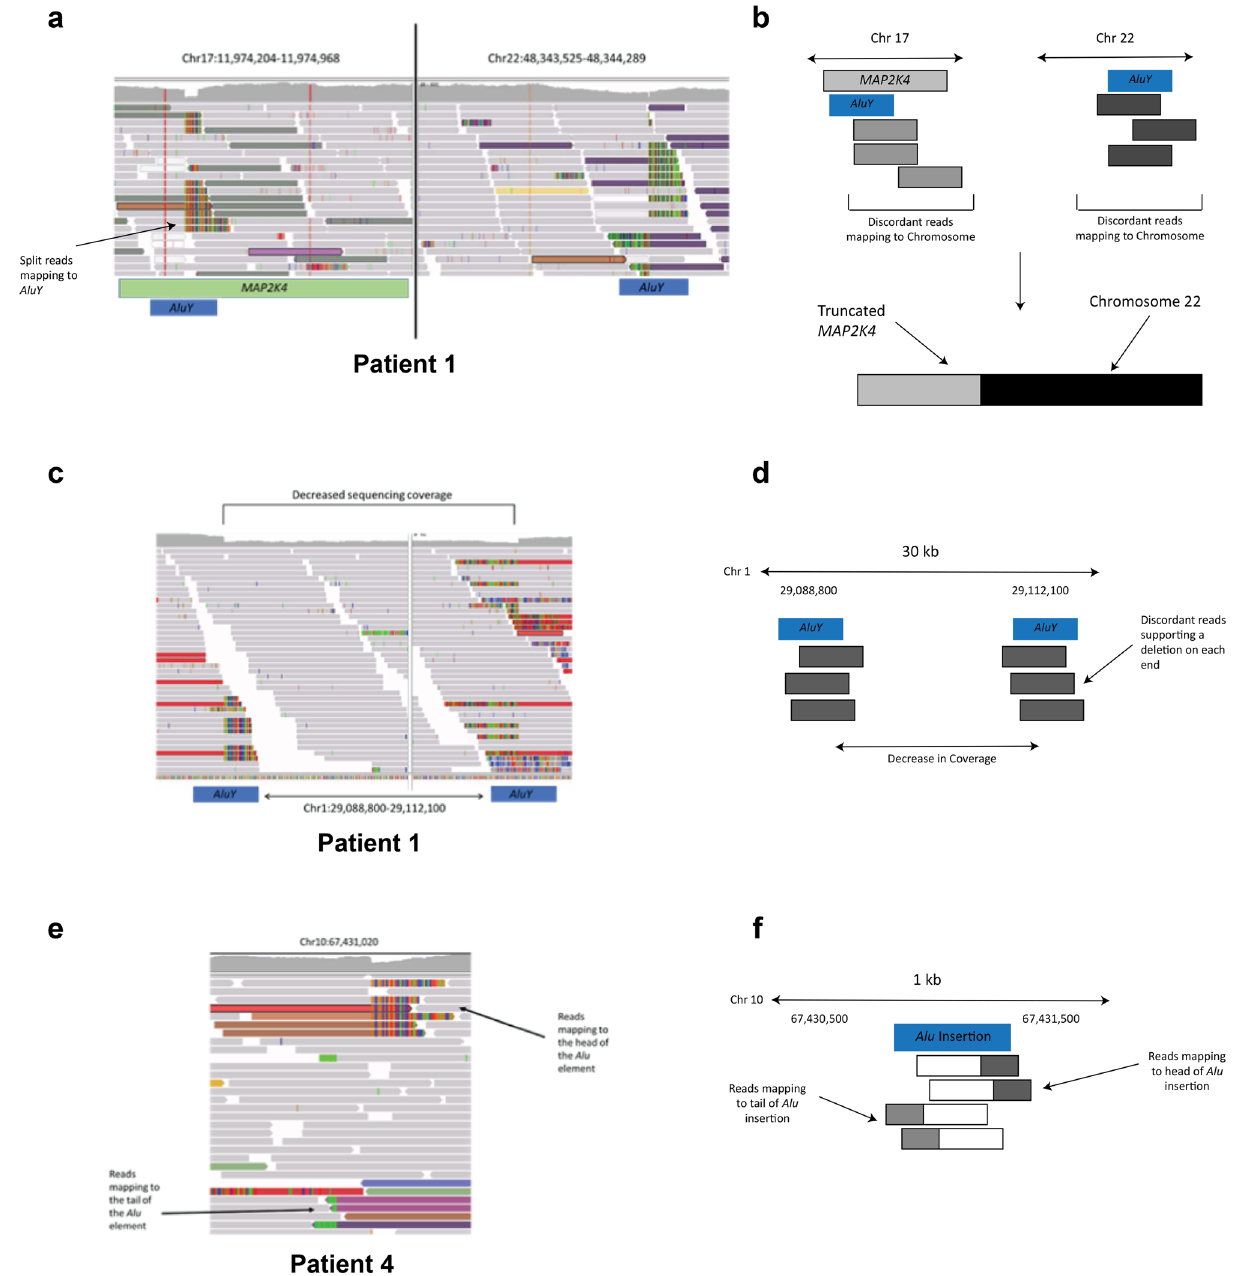
Figure 1. IGV images and schematics of some of the identified insertions and structural variants. ( A ) Image of the translocation between Chromosomes 17 and 22 in Patient 1 that interrupts MAP2K4 . Discordant reads on each chromosome map to the other end of the translocation. The split reads on Chromosome 17 map to a non- reference Alu element. The Alu element suspected to be involved in the translocation on Chromosome 17 (from the split reads) is shown as a blue box, and the reference Alu involved with the translocation on Chromosome 22 is also shown as a blue box. ( B ) A schematic showing the translocation event (not to scale). The Alu elements associated with the translocation are shown as blue boxes. The discordant reads are shown as gray or purple boxes. A schematic of the translocation is shown below the arrow. ( C ) Deletion involving Alu elements in Patient 1. Alu elements involved in the deletion are shown as blue boxes below the image. ( D ) A schematic of the deletion involving two Alu elements. Each Alu element is shown in blue, with the discordant reads shown in red. ( E ) Somatic Alu element insertion in Patient 4. The reads that map to the head and tail of the element are labeled by arrows. ( F ) A schematic of the Alu insertion on Chromosome 10. The approximate location of the insertion (blue box) is shown with the split and discordant reads mapping to the head of the Alu shown in white and red boxes, while the split and discordant reads mapping to the tail of the Alu are shown in white and green